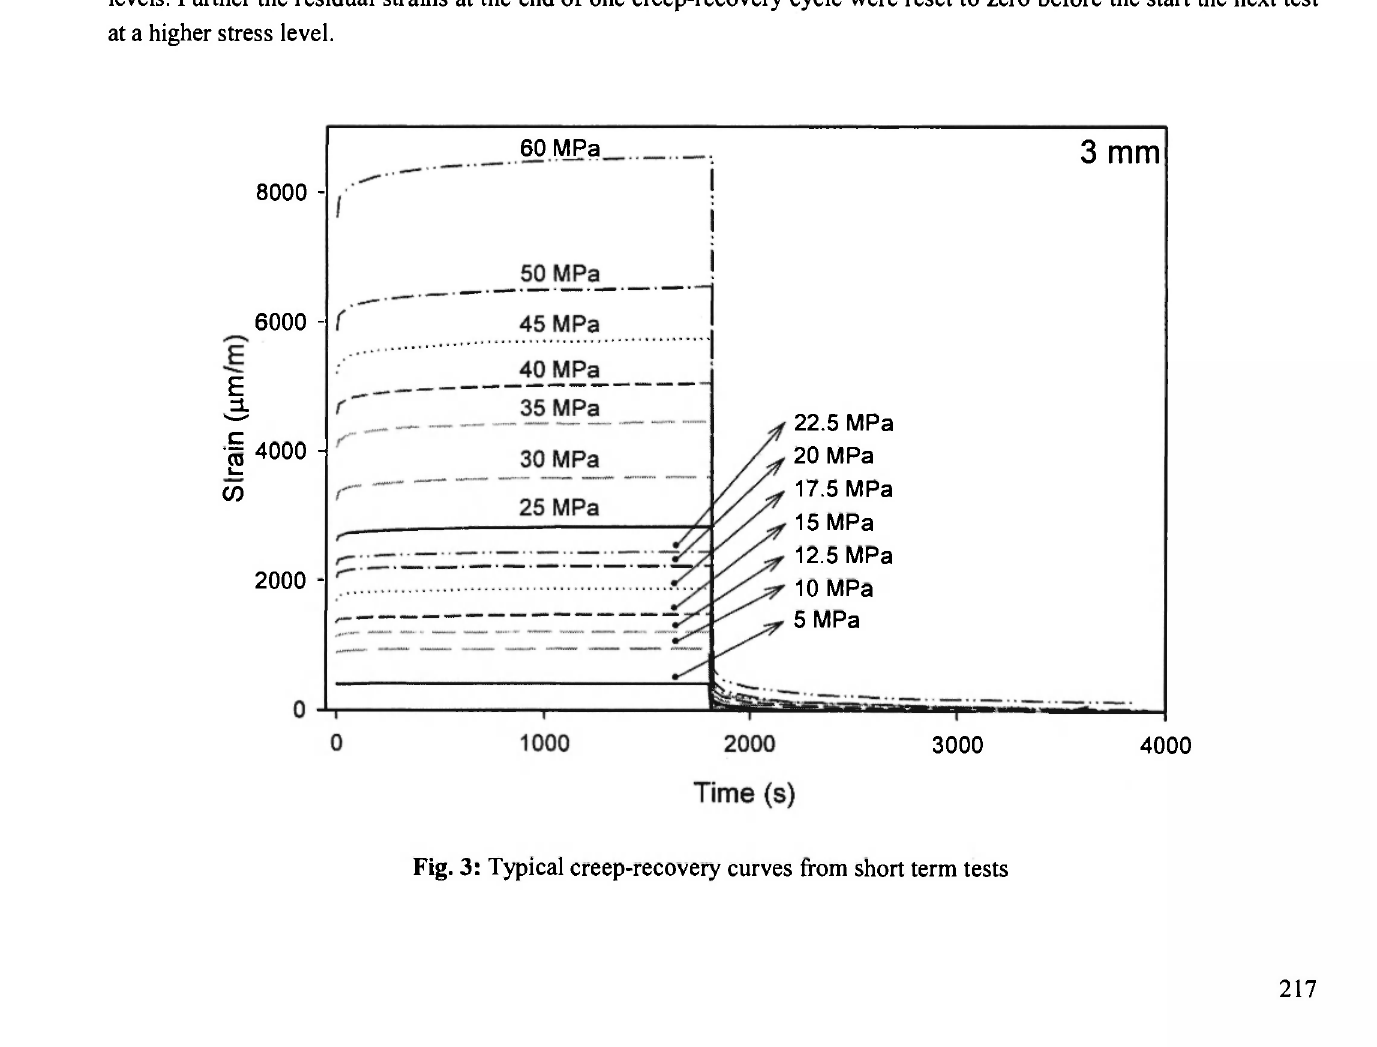
Fig. 3: Typical creep-recovery curves from short term